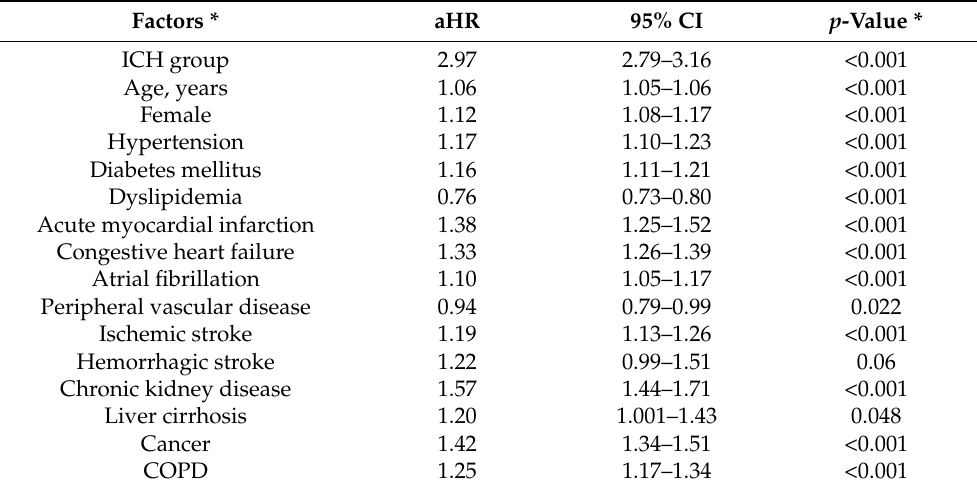
Table 3. Multivariable analysis of attributing factors for 12-month mortality.